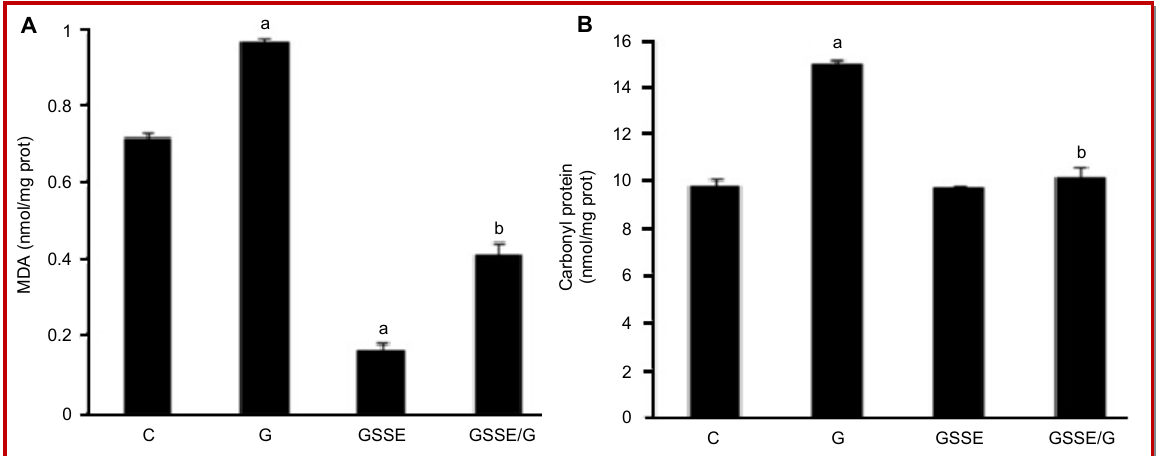
Figure 2: Effect of garlic and GSSE on renal lipoperoxidation and carbonylation. 10% ethanol (C), garlic (G), grape seed and skin extract (GSSE) or garlic plus GSSE (GSSE/G) were administered to rats for 1 month and renal lipoperoxidation (A) and car- bonylation (B) were determined. Results are expressed by mean ± SEM (n= 10). a p<0.01 vs C. b p<0.01 vs